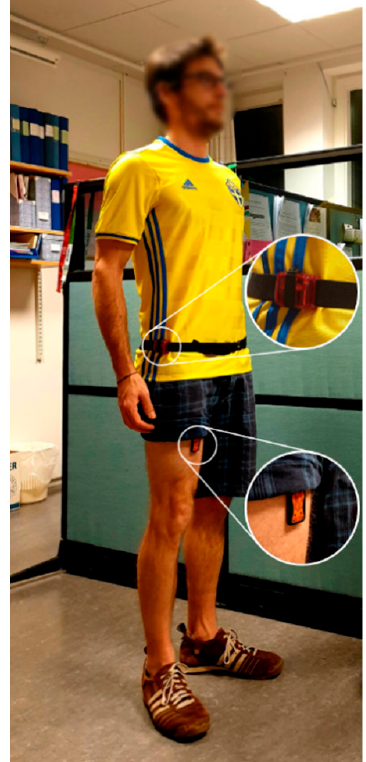
Figure 1. Illustrative figure of a participant wearing the activPal on the right thigh and the ActiGraph GT3X on a belt around the waist. For the measurement, the activPal was packed waterproof and covered with an adhesive patch.